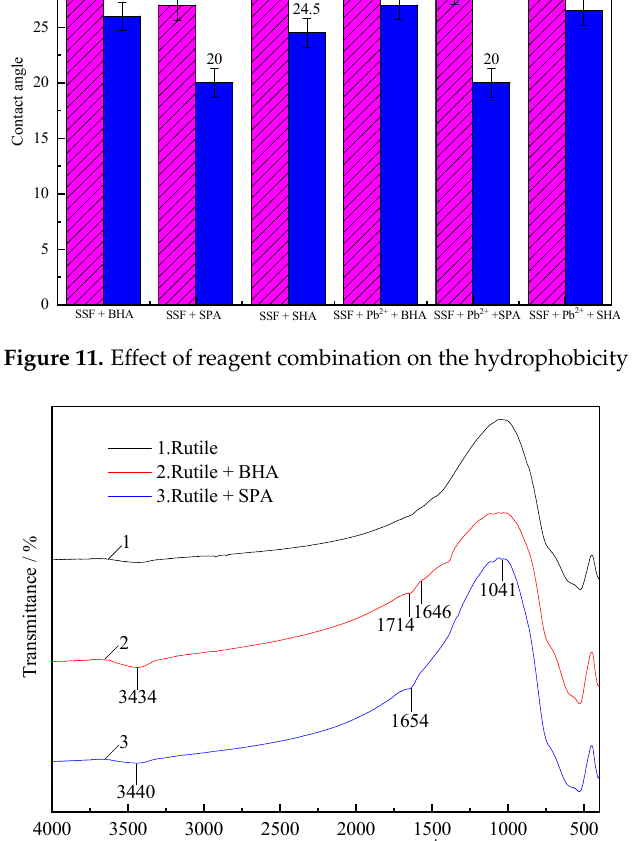
Figure 12. Infrared spectra of rutile before and after the interaction with reagents.